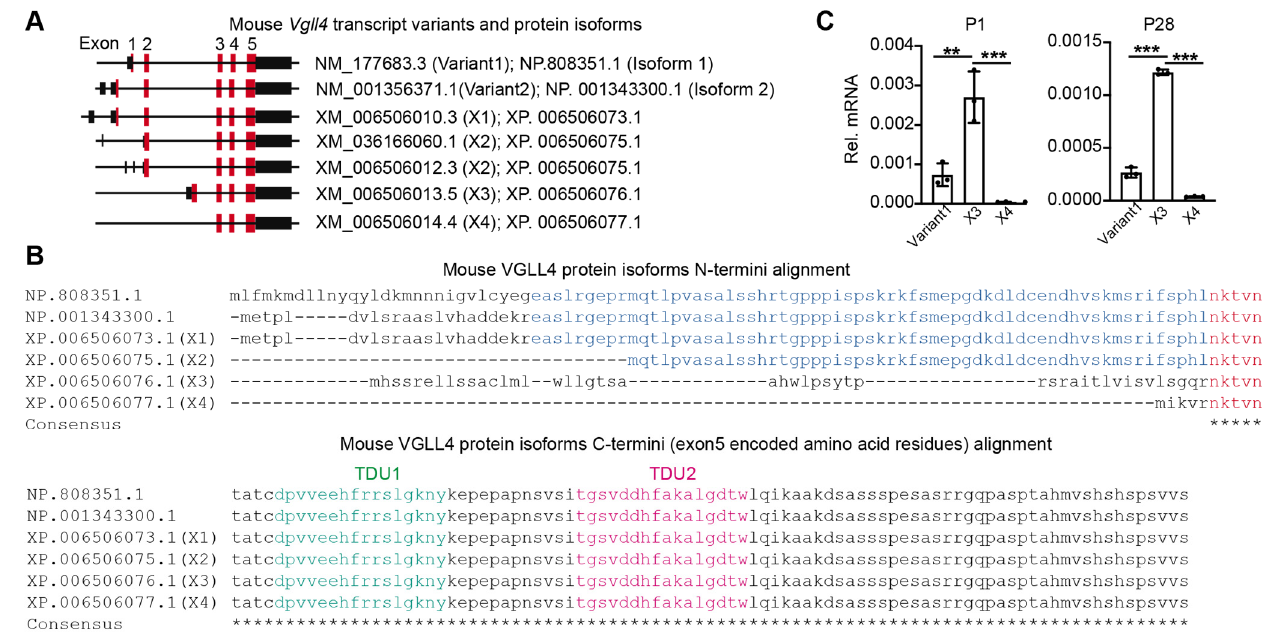
Figure 1. Vgll4 transcript variants and their protein products: ( A ) schematic view of mouse Vgll4 transcript variants. Black bars indicate non-translated mRNA sequences. Red bars indicate protein- coding sequences. The protein ID encoded by each variant was listed; ( B ) N-termini and C-termini alignments of mouse VGLL4 protein isoforms. N-termini alignment: blue and red letters indicate exon 2- and exon3-encoded amino acid residues, respectively. C-termini alignment: green and purple letters indicate TDU1 and TUD2 domains, respectively; ( C ) qRT-PCR measurement of three Vgll4 transcript variants. Each dot indicates a data point from one individual animal. Total RNA from P1 and P28 hearts were used for qRT-PCR test. mRNA level of each isoform was normalized to Gapdh . One-way ANOVA test, ** p < 0.01, *** p < 0.001. N = 3.